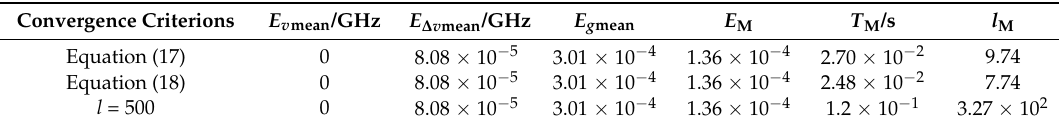
Table 2. Statistical results of errors in the extracted key parameters corresponding to different convergence criterions and the corresponding computation